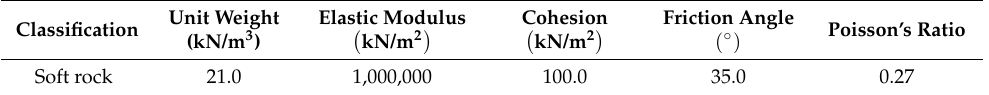
Table 2. Continuum material properties of soft